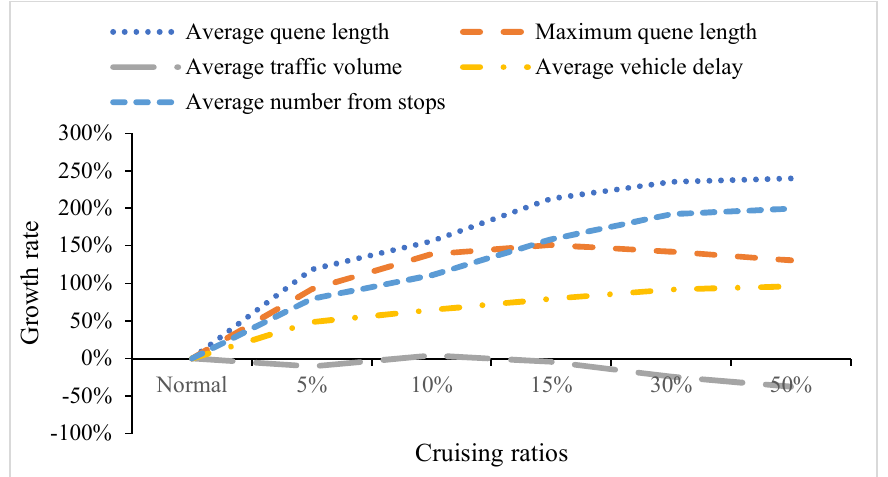
Figure 17. Five MOEs’ growth rate.